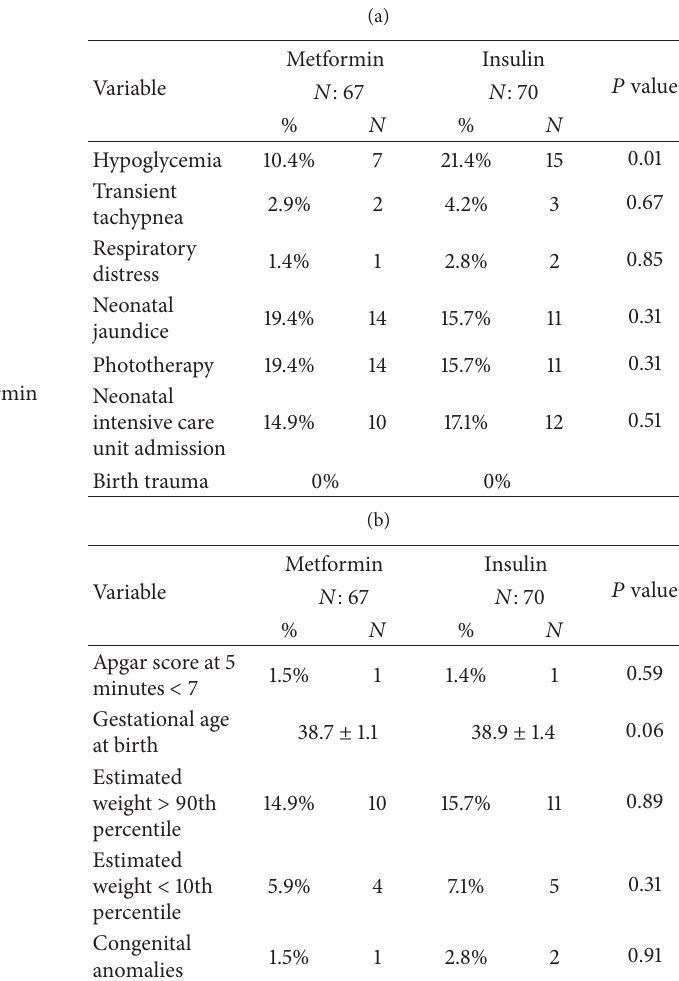
Table 5: Neonatal